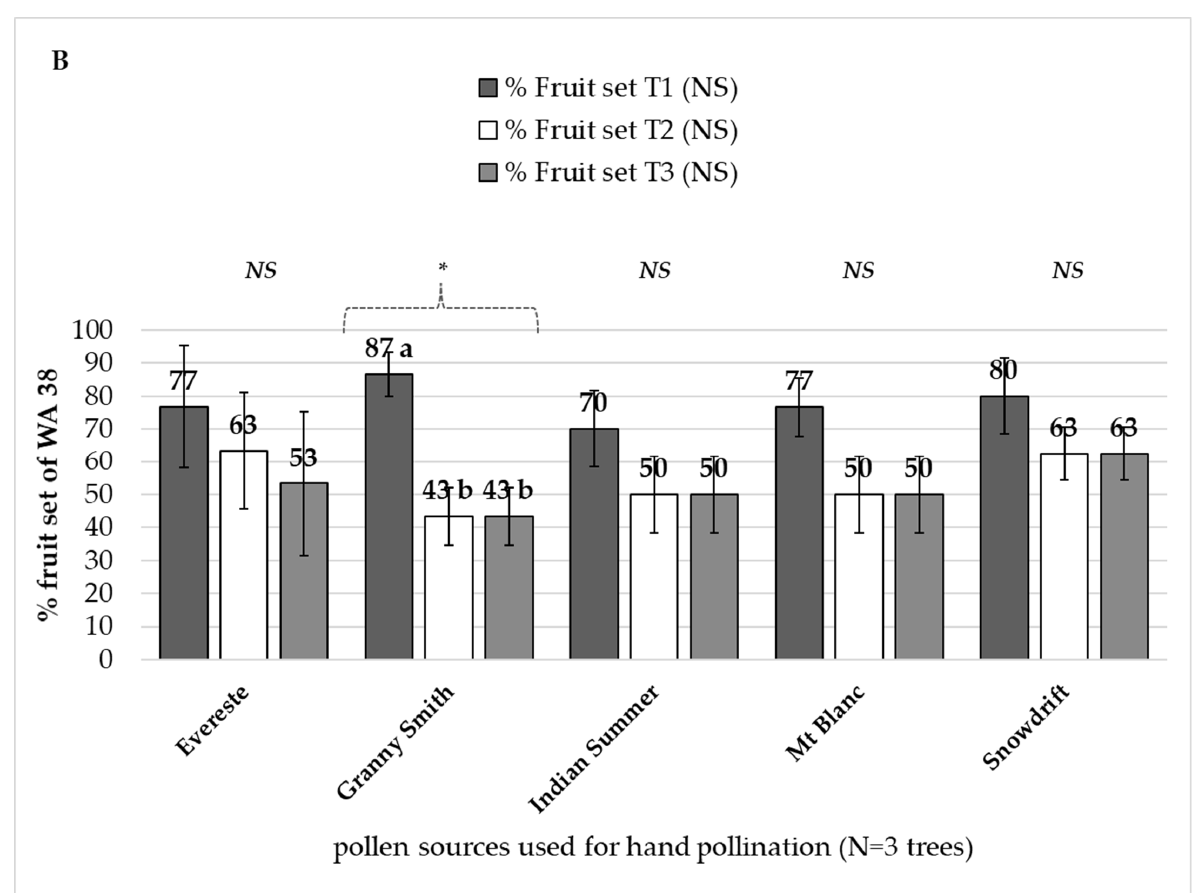
Figure 2. ‘WA 38’ fruit set (%) by pollen source in May (T1), June (T2), and September (T3) in ( A ) 2019 and ( B ) 2020. Ten flowers on each of three trees per pollen source were pollinated by hand, and the fruit set is presented here as the average of three trees ( n = 3). Error bars represent the standard error of the mean (SE). Statistical significance for the comparison of fruit set (%) across pollen sources within each time of assessment is reported in the legend, and significance for the comparison of fruit set (%) across time point assessments within each pollen source is indicated above the braces (* = p < 0.05, *** = p < 0.001 NS = not significant). When the model showed significance, means were then separated with the SNK post-hoc test within each pollen source by fruit set assessment (T1, T2, and T3), where different letters indicate significant differences between fruit set (%) at the different time points of assessment. In 2019: T1 = 14 May 2019, T2 = 14 June 2019, and T3 = 24 September 2019;